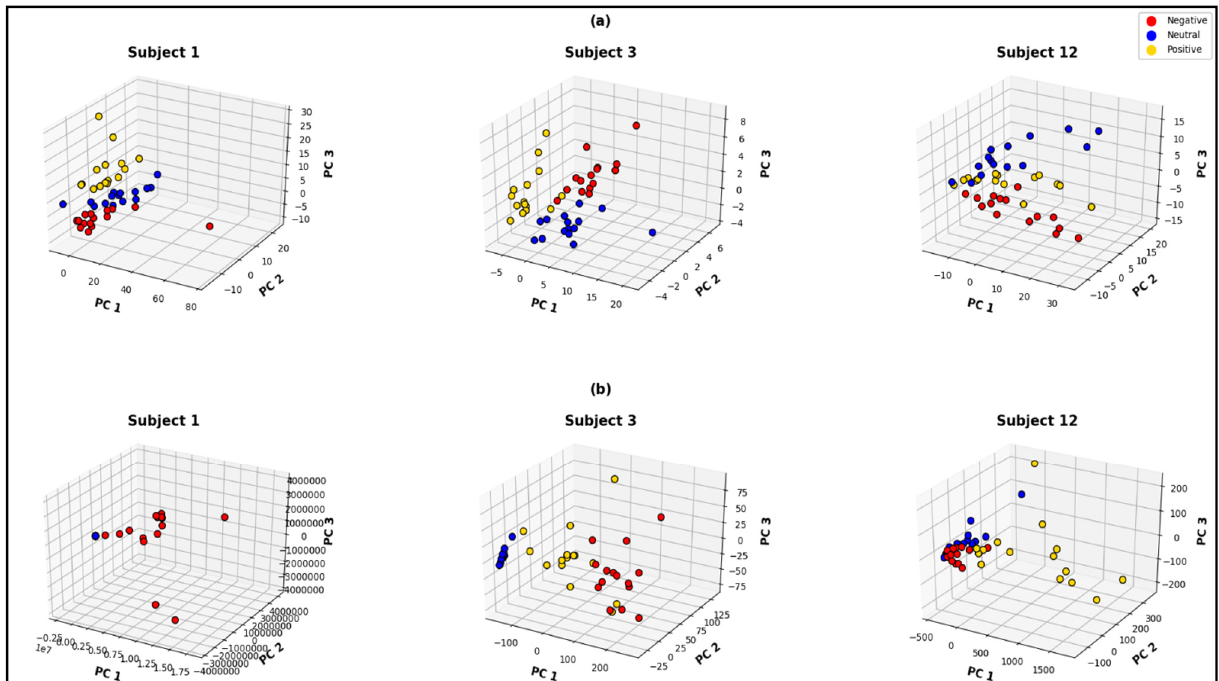
Figure 11. Three-dimensional principal-component visualization of ( a ) the computed MUSIC feature space and ( b ) non-parametric (Welch) feature space considering all 62 channels.